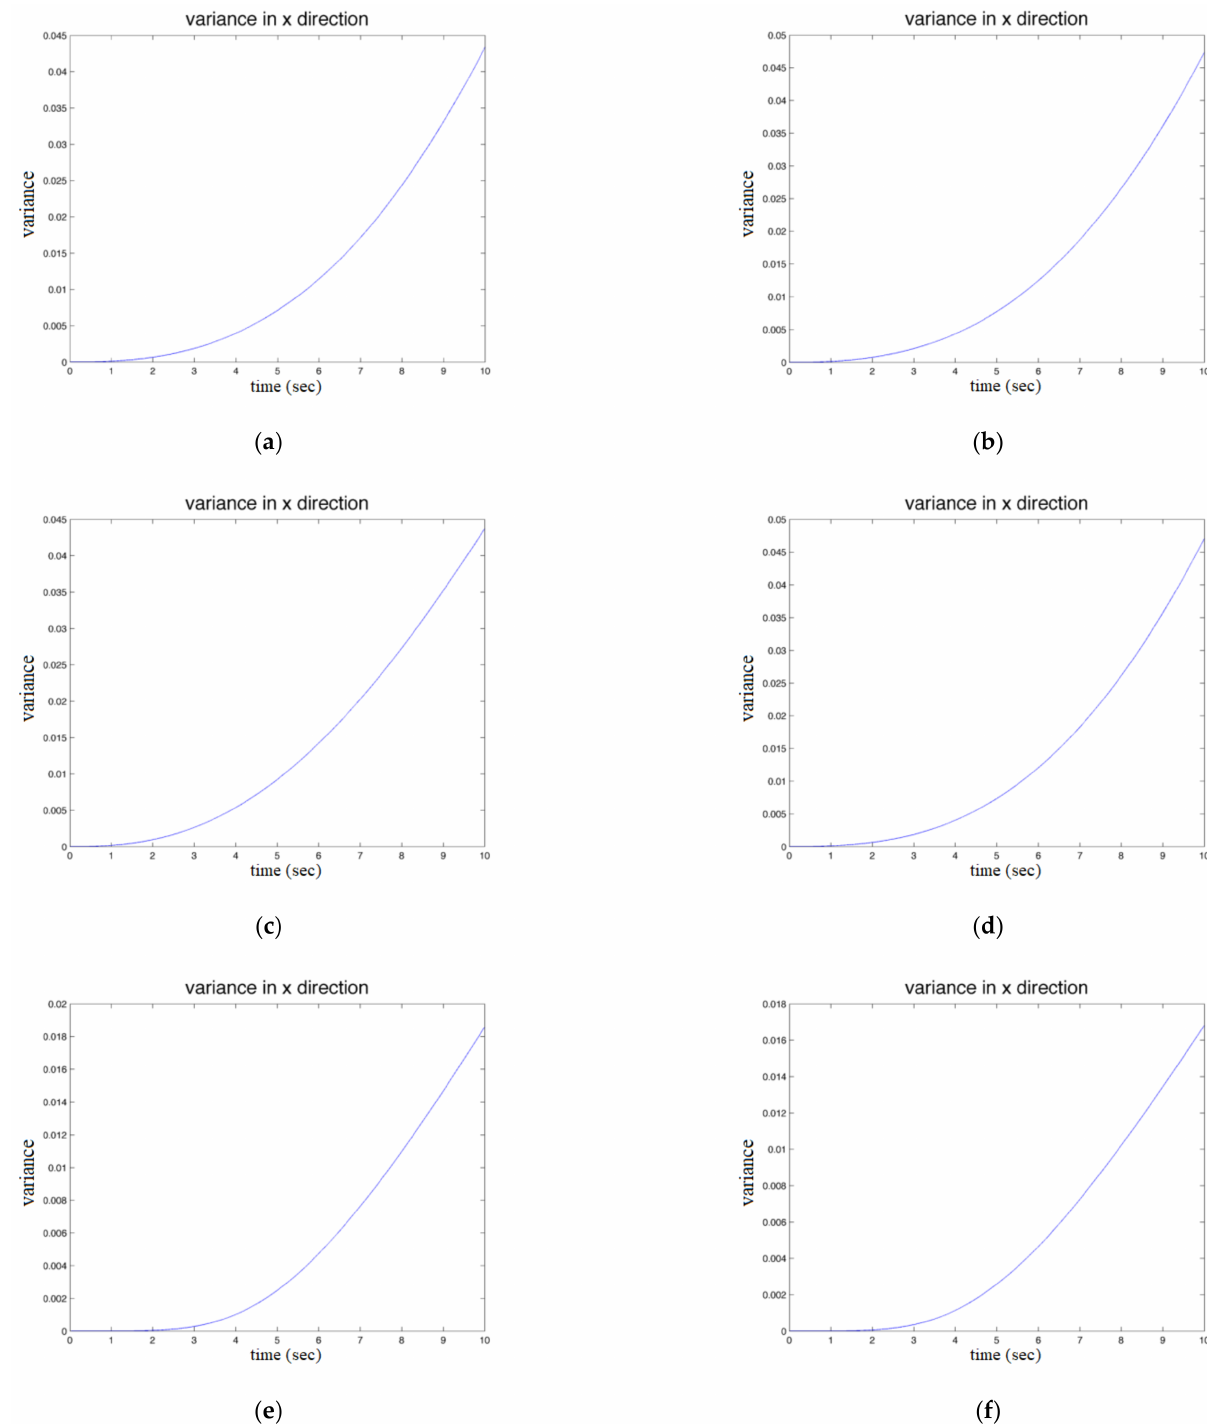
Figure 6. Final particle location variance in the x-direction: ( a ) final probable source location variance in backward tracking tests with the diffusivity of Rouse [37], using the explicit method; ( b ) final probable source location variance in backward tracking tests with the diffusivity of Rouse [37], using the implicit method; ( c ) final probable source location variance in backward tracking tests with the diffusivity of Absi et al. [38], using the explicit method; ( d ) final probable source location variance in backward tracking tests with the diffusivity of Absi et al. [38], using the implicit method; ( e ) final particle location variance in forward tracking tests with the diffusivity of Rouse [37], using the explicit method; ( f ) final particle location variance in forward tracking tests with the diffusivity of Absi et al. [38], using the explicit